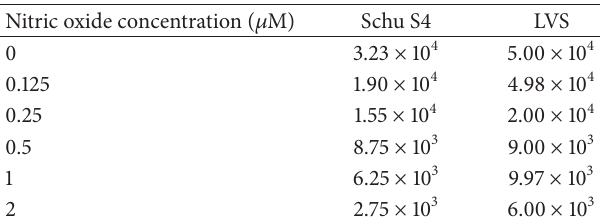
Table 2: Effect of increased concentration of nitric oxide on bacterial counts (cfu/mL) after 1 hr incubation in PBS. Nitric oxide concentration ( 𝜇 M) Schu S4